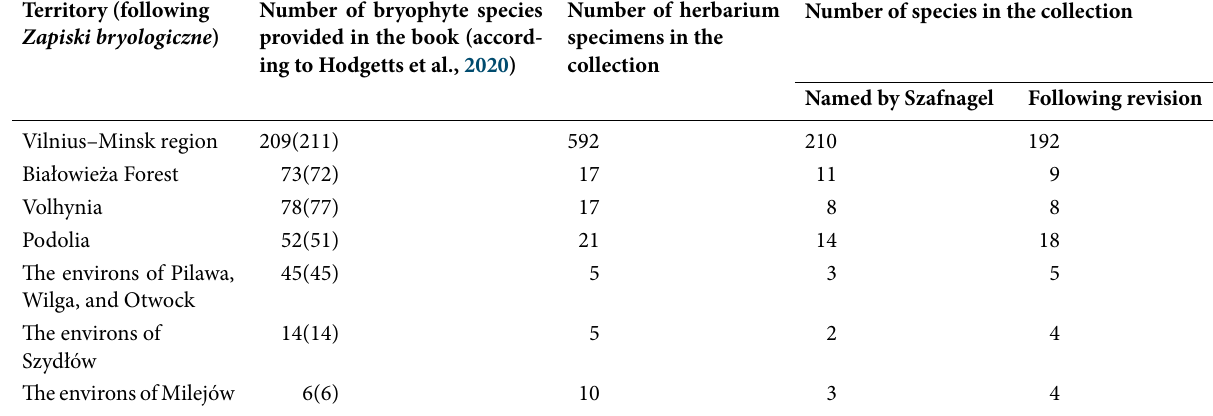
Table 1 Szafnagel’s data on bryophyte diversity in the regions investigated by him in 1882–1885. Territory (following Zapiski bryologiczne